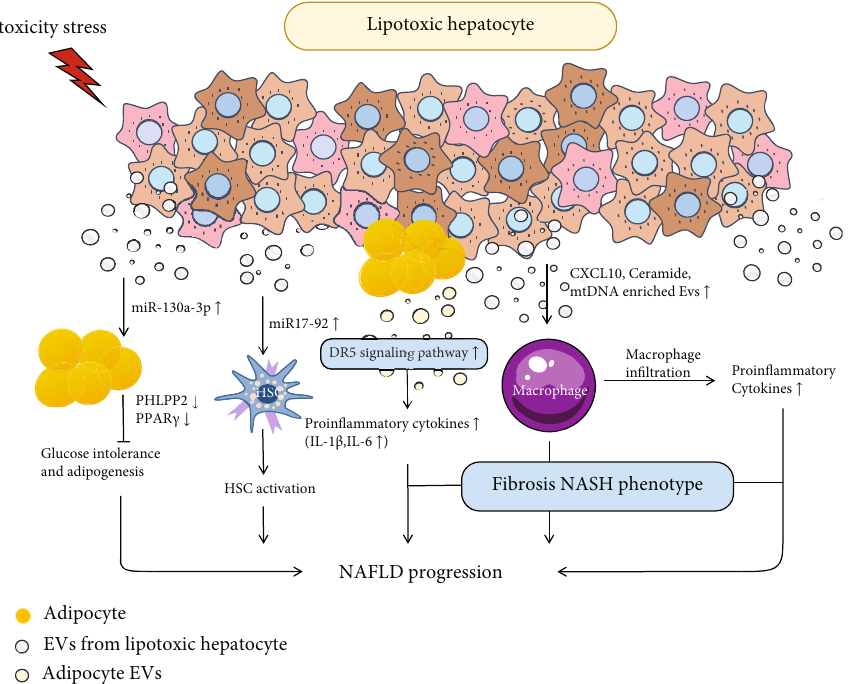
Figure 3: Exosomes in progression of alcohol-associated liver disease (NAFLD). In the progression of NAFLD, various lipotoxic stimuli promote hepatocyte steatosis and promote the release of hepatocyte-derived exosomes. The exosomes released carry components composed of proteins, RNAs, and lipids. Exosomes promote the progression of NAFLD. On the one hand, it facilitates the in fi ltration of immune cells in liver and promotes liver in fl ammation; on the other hand, it participates in insulin resistance and activates stellate